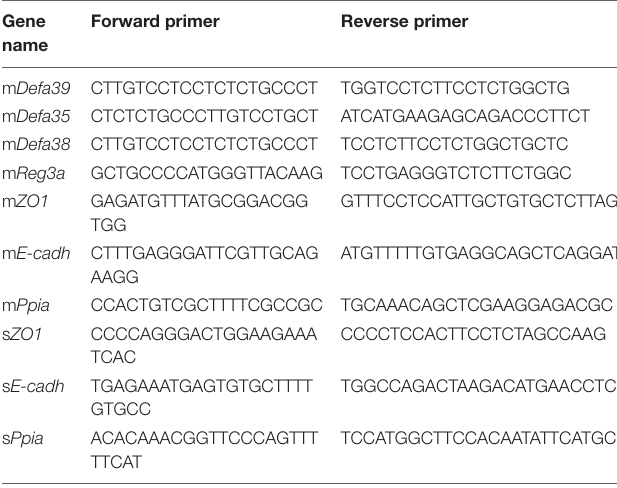
TABLE 1 | Primers for -2 (cid:49)(cid:49) Ct method qRT-PCR in this